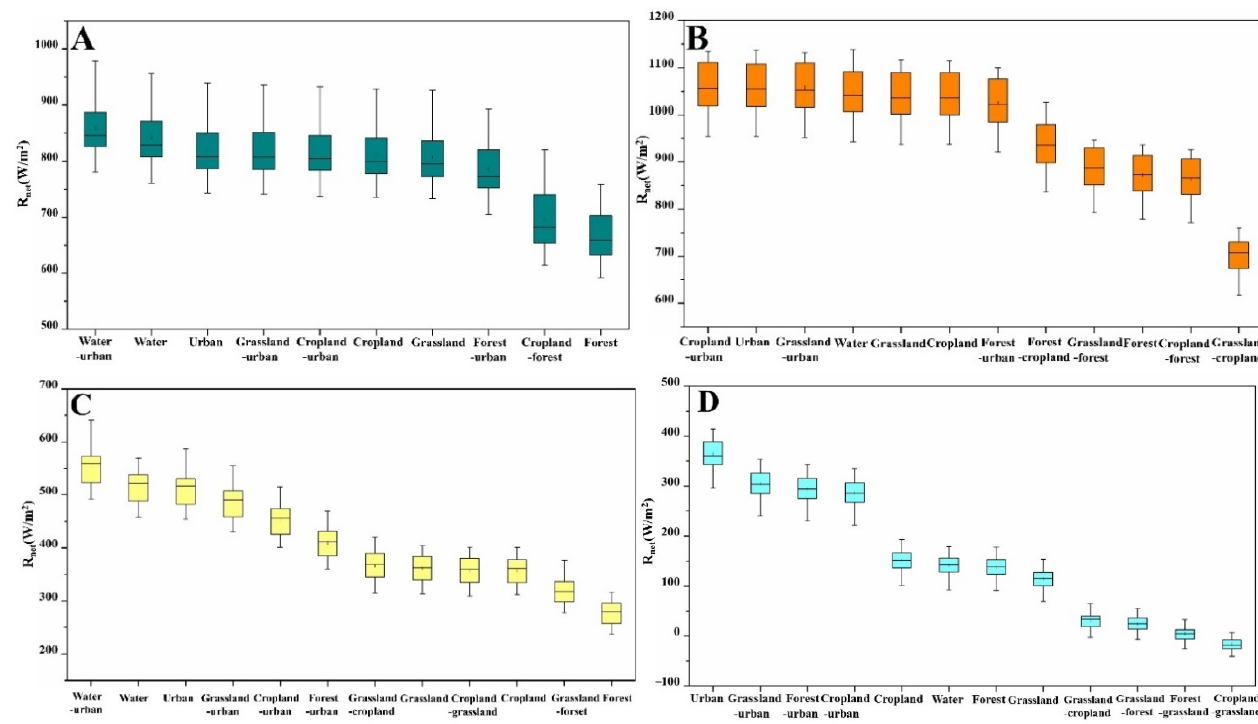
Figure 13. Statistical characteristic values of net radiation based on different land types from 2000 to 2015 (( A ) Jinan City, ( B ) Zhengzhou City, ( C ) Lanzhou City, ( D ) Xining City).